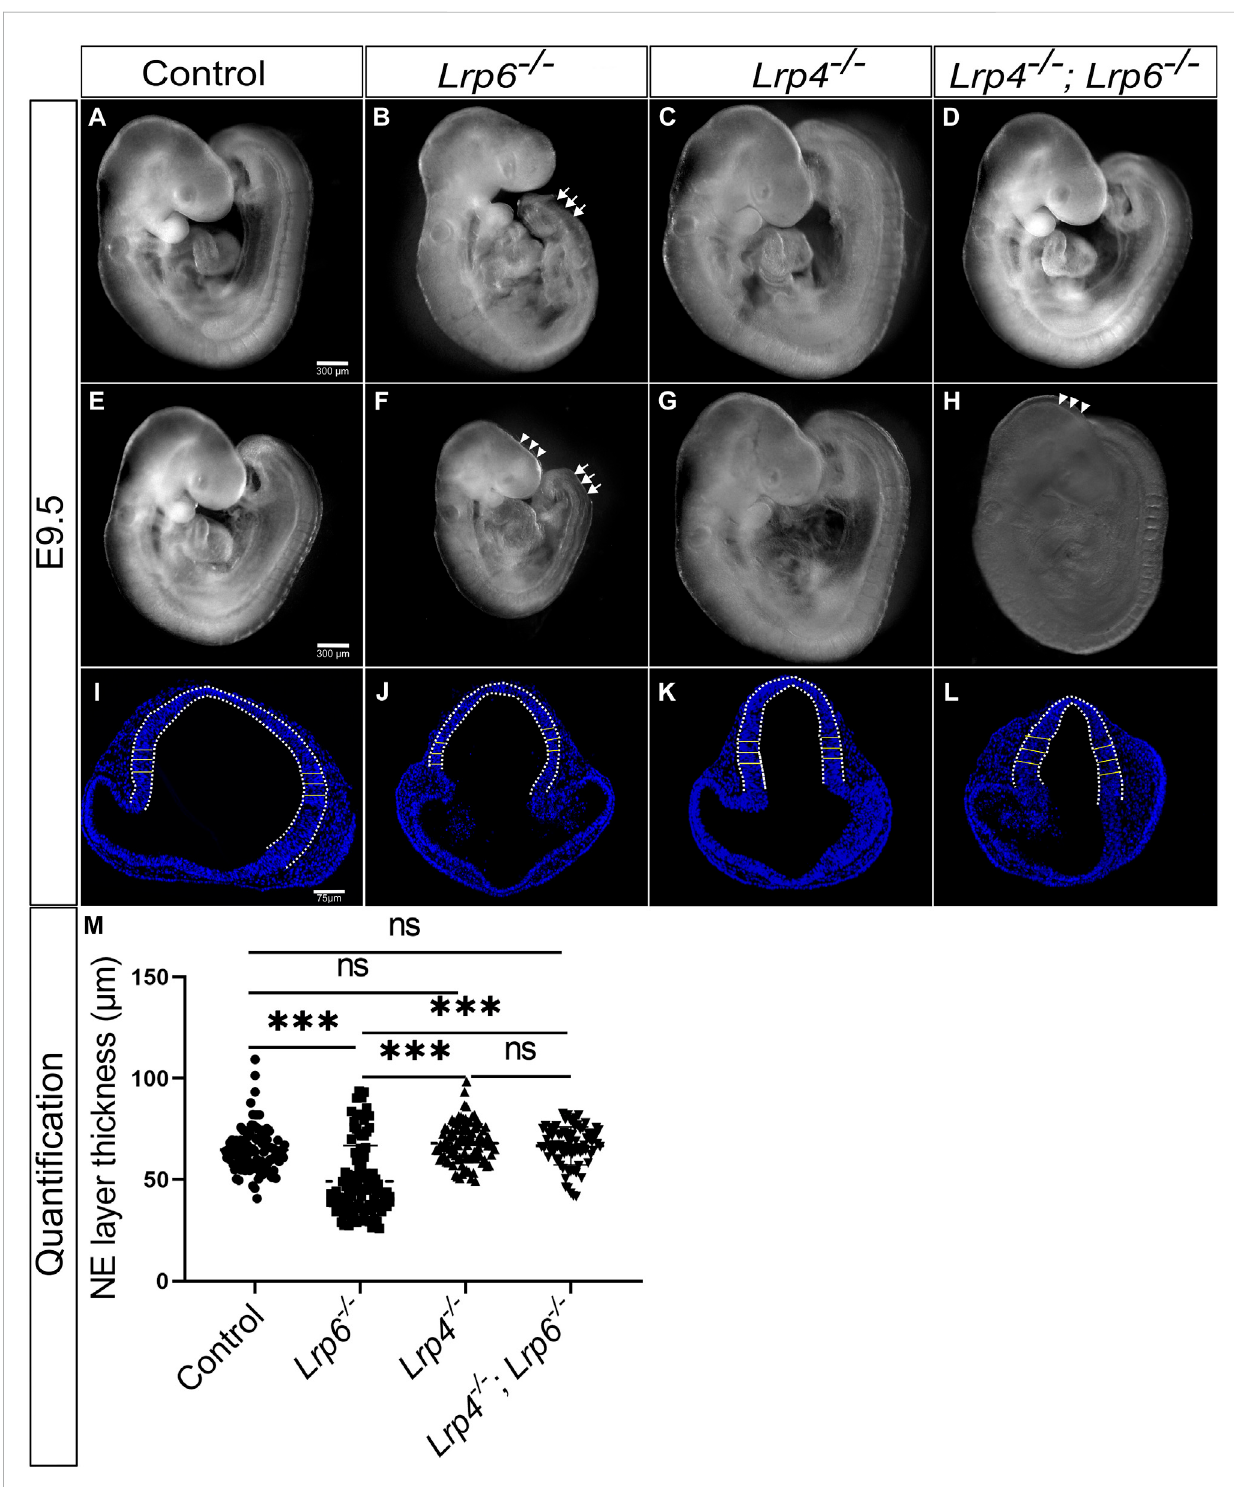
FIGURE 3 Genetic ablation of LRP4 function in rescues neuroepithelial hypoplasia but not cranial neural tube defects (NTDs) in Lrp6 − / − mutants. (A – H) Lateral viewsofwholeembryosatE9.5.Asreportedbefore,thecaudaltruncationphenotypewasfullypenetrantin Lrp6 − / − mutants[ (B,F) ,arrows].32%of Lrp6 − / − mutants(8outof25)displayedcranialNTDs[ (F) ,arrowheads]comparedtostagematchedlittermatewild-typecontrols (A,E) and68%of Lrp6 − / − mutants (17 out of 25) had a closed cranial neural tube (B) . Lrp4 − / − mutants (C, G) showed a cross morphology comparable to wild-type controls and never displayed NTDs. Lrp4 − / − ; Lrp6 − / − double mutants had a less severe caudal truncation (D, H) , the cranial NTD however was seen in a similar frequency as in Lrp6 − / − mutants. 62.5% of the Lrp4 − / − ; Lrp6 − / − mutants (15 out of 24) had a closed anterior neural tube (D) whereas 37.5% (9 out of 24) Lrp4 − / − ; Lrp6 − / − mutants suffered from cranial NTDs (H) . Scale bars: 300 µm. (I – L) Representative images of DAPI stained coronal sections with the bars indicating the thickness of the forebrain neuroepithelium at E9.5 measured along the dorsolateral domain indicated by the dotted line. Lrp6 − / − mutants (J) displayed